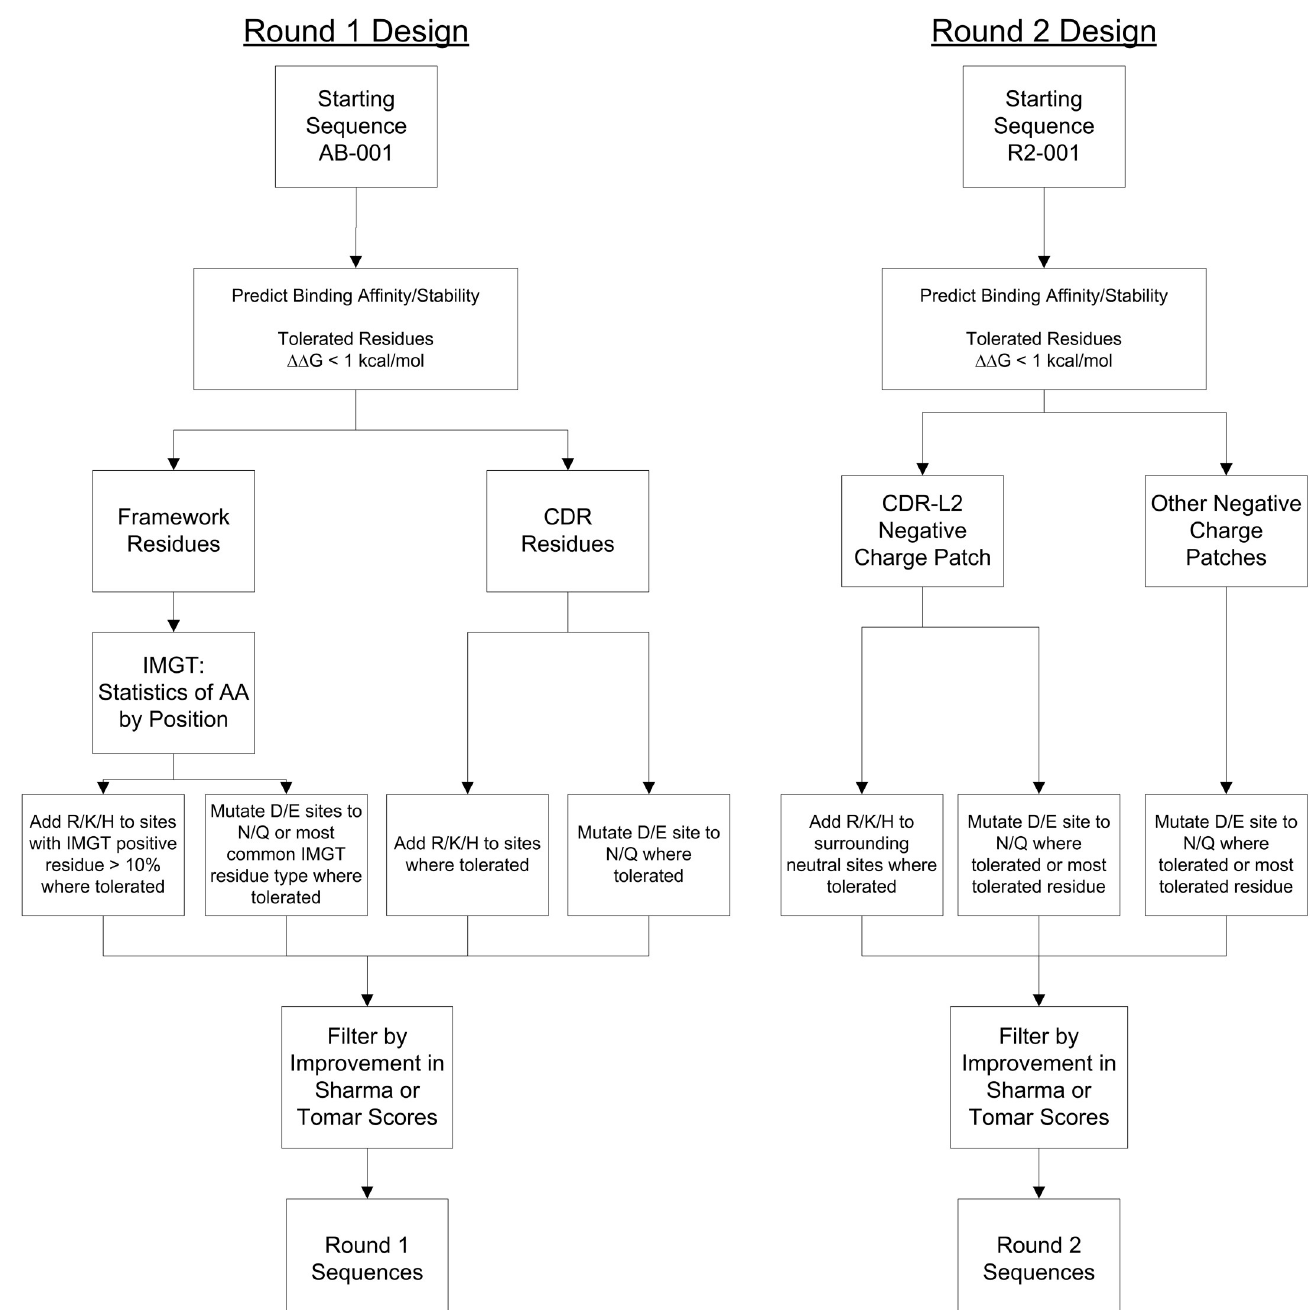
Fig 2. Flowchart for the round 1 and round 2 design